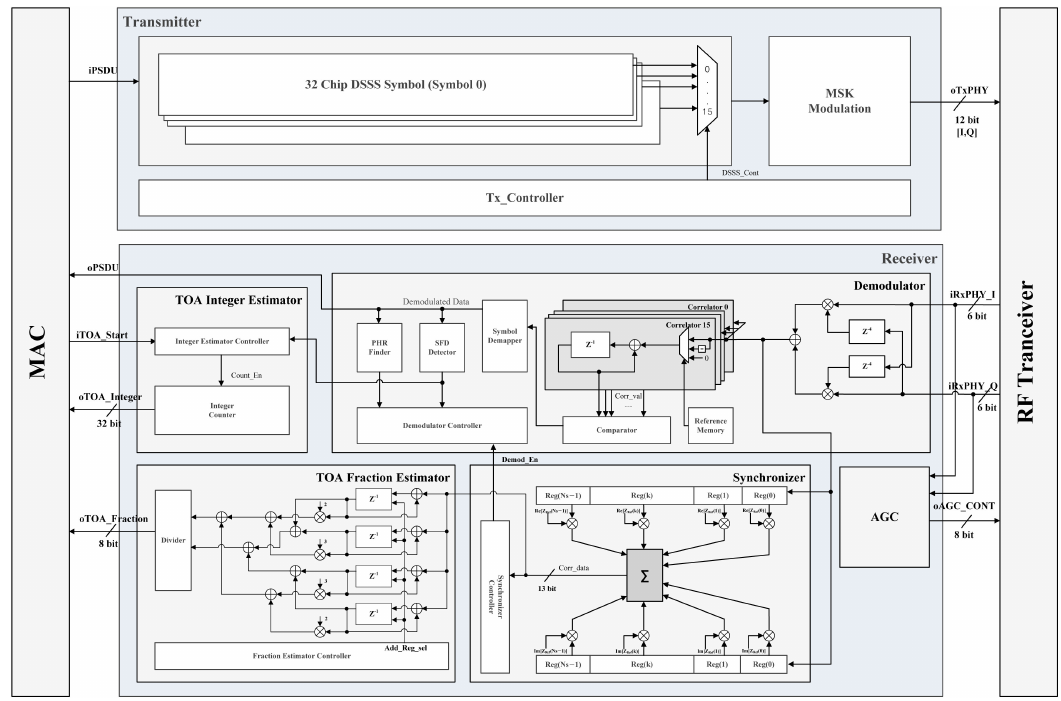
Figure 10. Block diagram of ZigBee baseband modem with proposed TOA